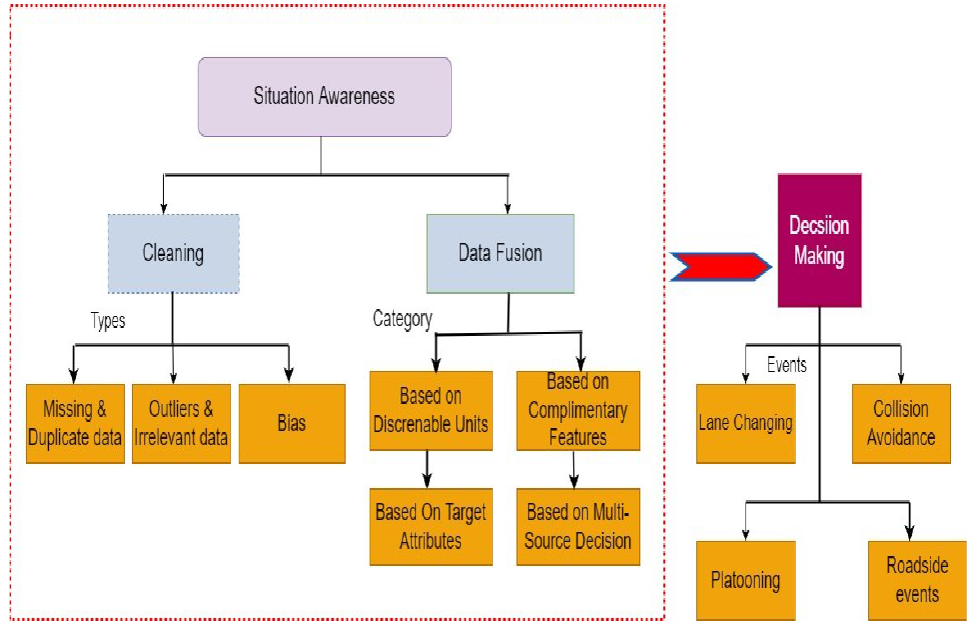
Figure 1. Overall flow of the